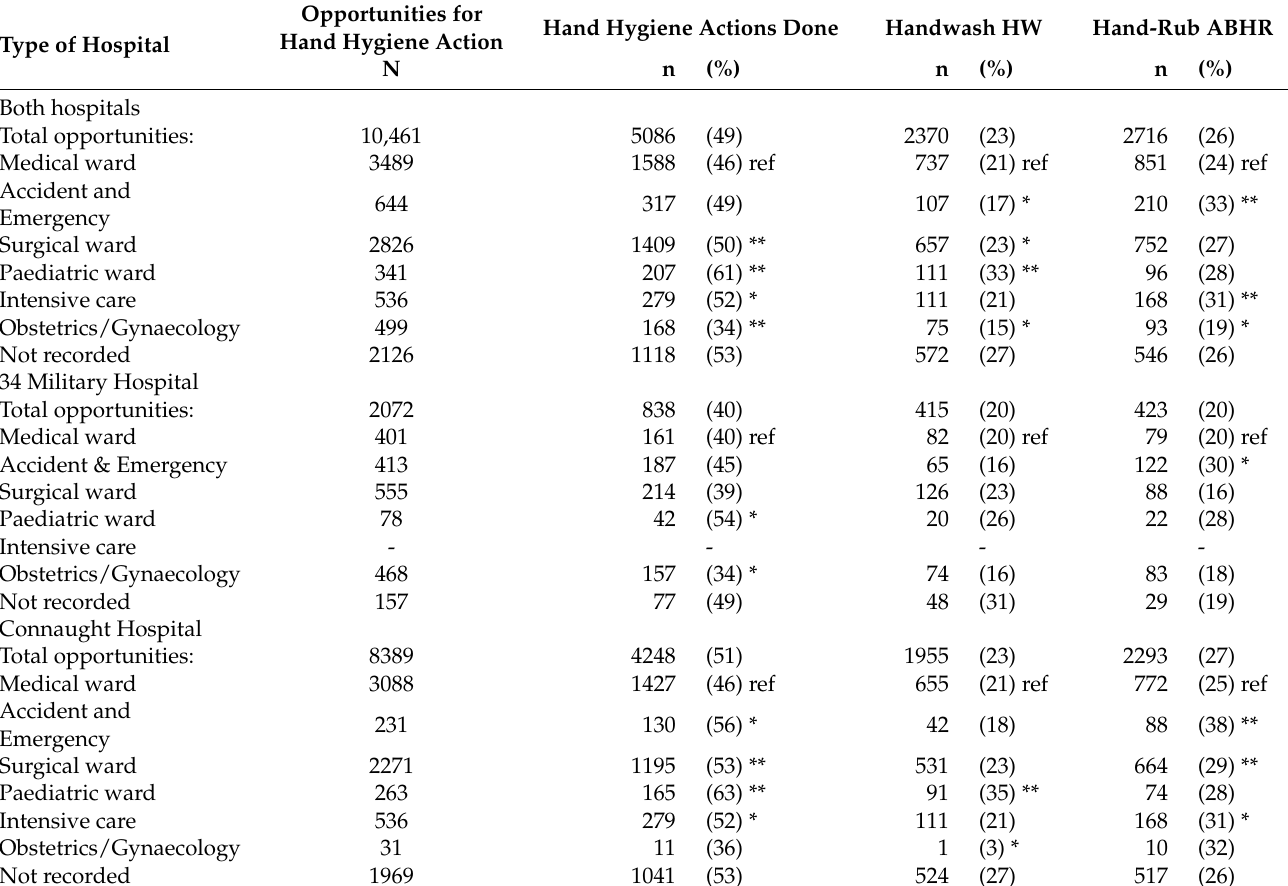
Table 2. Hand hygiene compliance within the two tertiary hospitals in relation to